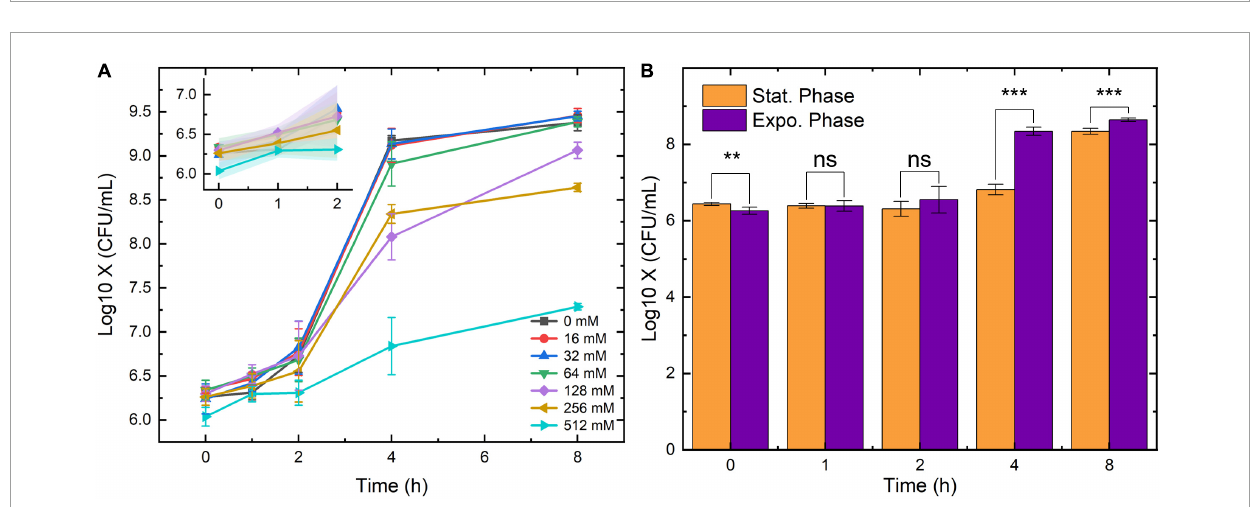
FIGURE2 The growth curves of exponential Escherichia coli under the pressure of seven SA concentrations (A) and the growth comparison between the stationary and the exponential E. coli under 256-mM SA (B) . 0-mM SA serves as the negative control. Error bars and error ribbons represent the standard deviation of five biological replicates. Statistical significance was calculated ( t -test) and marked accordingly. *** p ≤ 0.001; ** p > 0.05, no significance